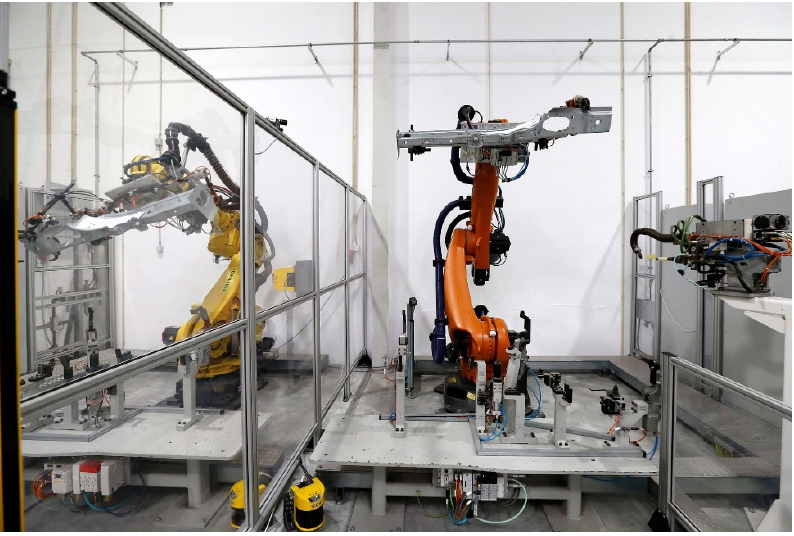
Figure 3. Introsys welding industrial robotic cells (Left: VW station; Right: Ford station).